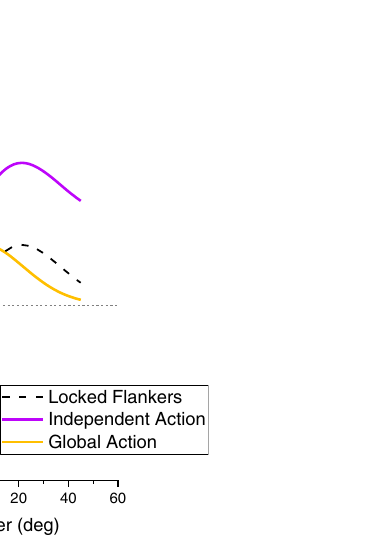
Fig. 3 | Flanker integration decreases with distance, a signature of crowding. a Response bias as function of fl anker orientation for various target- fl anker dis- tances leading to four different normalized target- fl anker distances (distance between fl ankerandtargetcentresdividedbyeccentricity).Dataareobtainedfrom N =5 observers and are fi t with a derivative of gaussian function with free